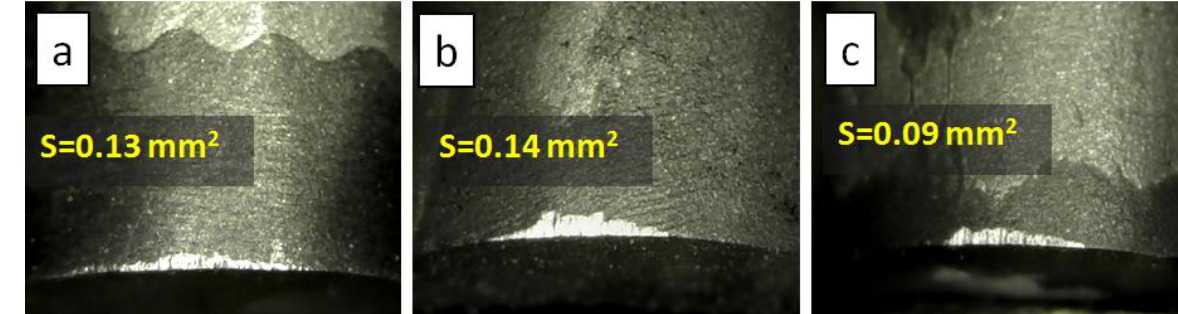
Figure 6. Photographs of wear spots of diamond composites taken after turning of hard alloy WC- 8Co blanks: ( a ) commercial PDC from US Synthetic; ( b ) composite obtained from a mixture of FDM-2Al-6Co, and ( c ) nickel infiltrated FDM-2Al-6Co composite.